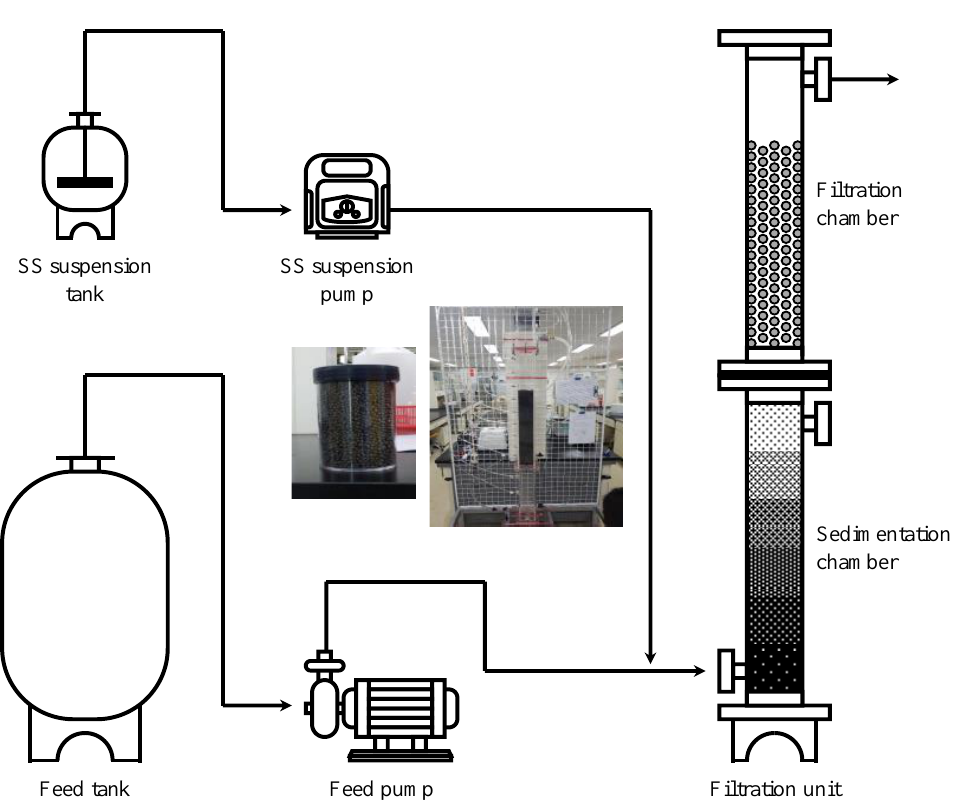
Figure 1. A schematic diagram of the laboratory-scale filtration system with inset photographic images of the granular media (left) and filtration chamber (right).